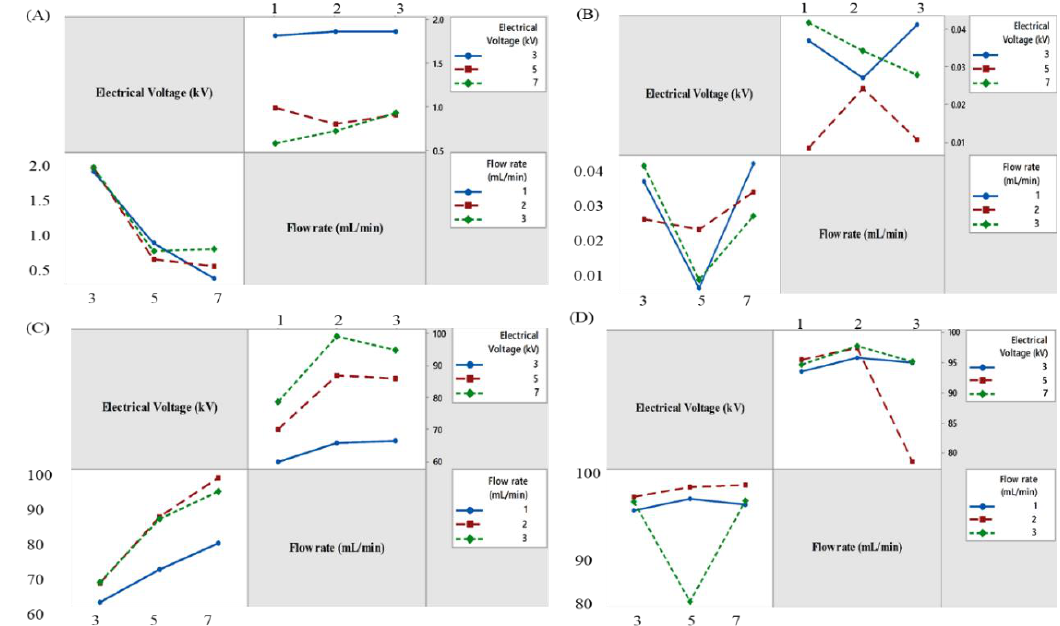
Figure 4. Interaction effect plots of BSO-loaded alginate beads on size ( A ), sphericity factor (SF) ( B ), encapsulation efficiency (EE%) ( C ), % cumulative drug release at 2 h ( D ). Data were presented as mean value ( n = 3).